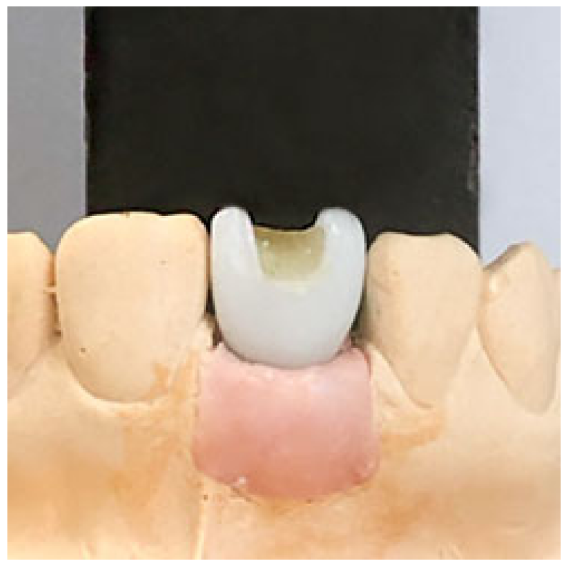
Fig. 2 Composite lid. Zirconia crown with composite covered venting